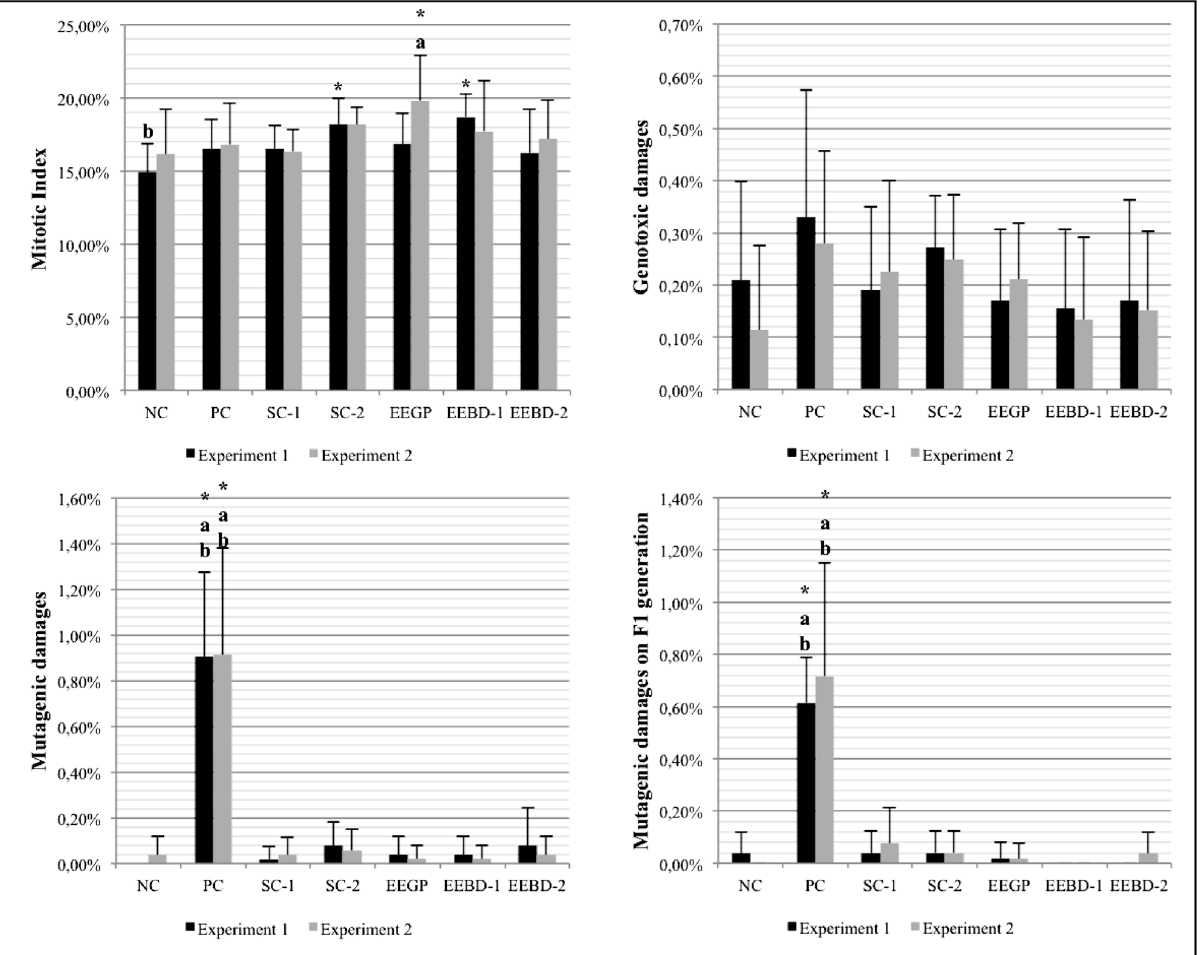
Figure 5 - Results obtained with the third collection of A. cepa roots, which were used to evaluate the continuing effects of the ethanolic extracts over the cells(recoveryassay).NC:negativecontrol;PC:positivecontrol;SC-1:solventcontrol1(ethanol-0.042 (cid:2) L/mL);SC-2:solventcontrol2(ethanol-0.21 (cid:2) L/mL); EEGP: ethanolic extract of Brazilian green propolis; EEBD-1: ethanolic extract of Baccharis dracunculifolia (0.06 (cid:2) L/mL); EEBD-2: ethanolic extract of Baccharis dracunculifolia (0.30 (cid:2) L/mL). * ,a,b Statistically significant when compared to the NC, SC-1 and SC-2, respectively, by the Kruskal-Wallis/Dunn’s test (p <